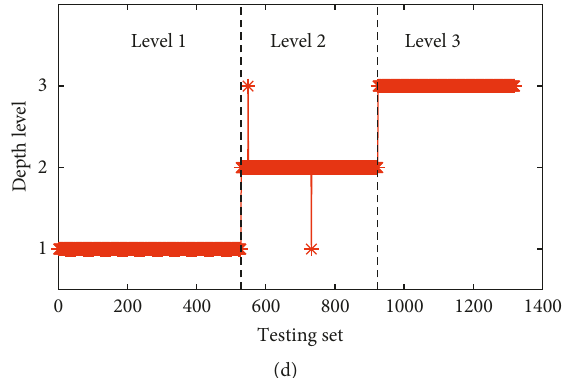
Figure 13: The classification results of rail corrugation depth